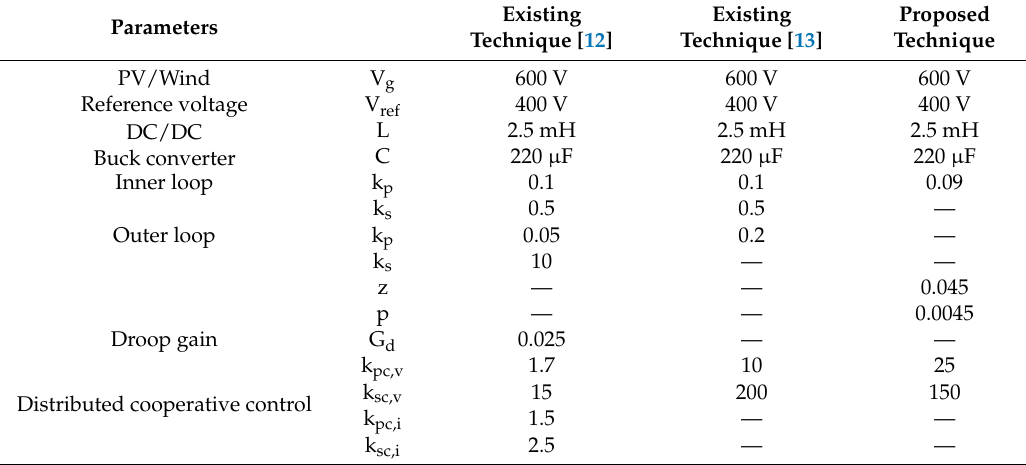
Table 3. System design parameters.